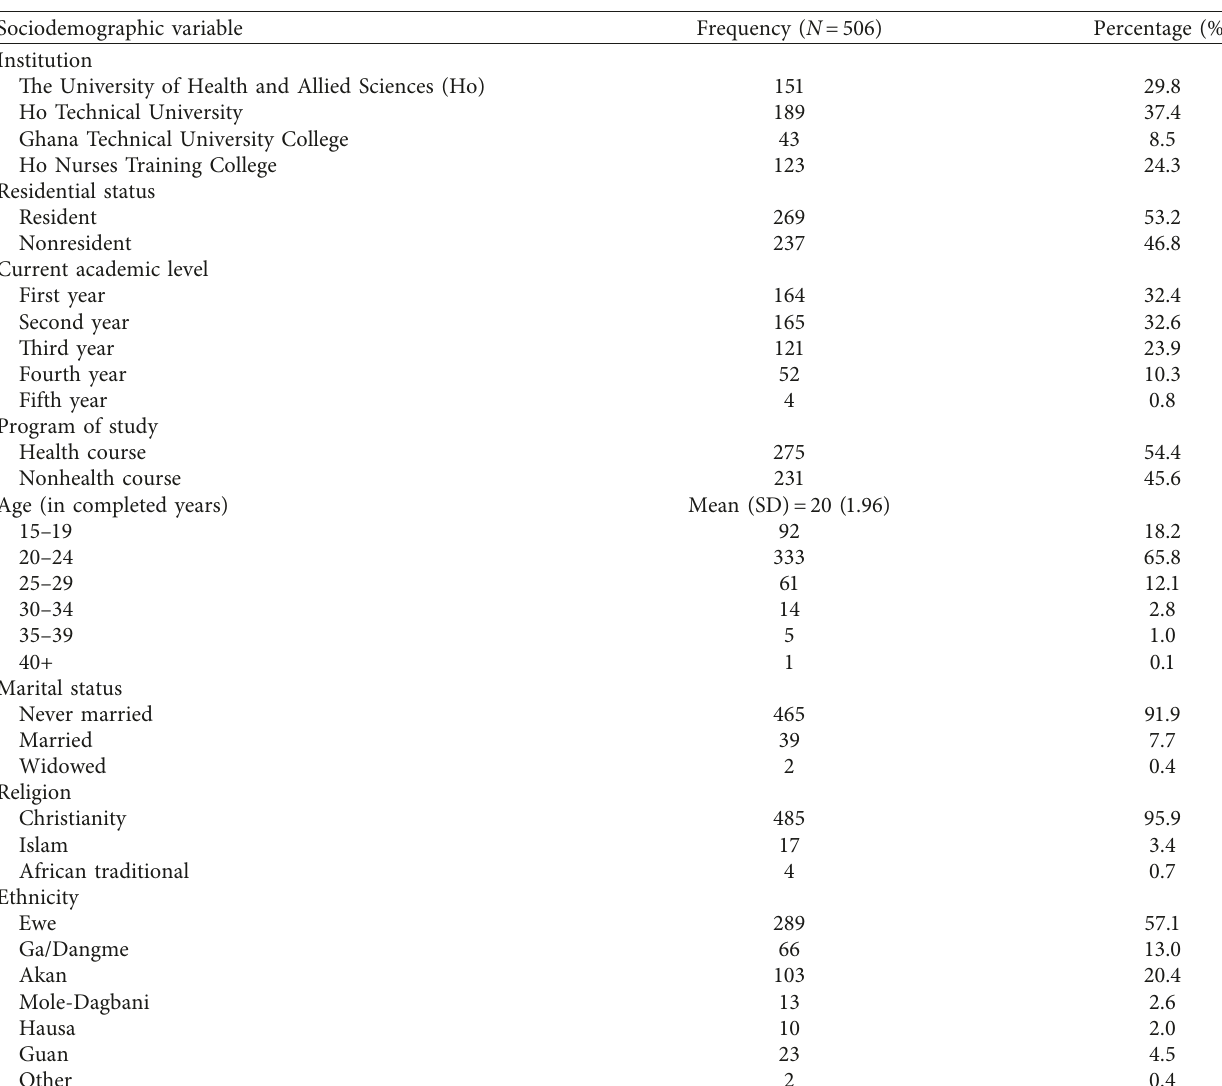
Table 1: Sociodemographic characteristics of